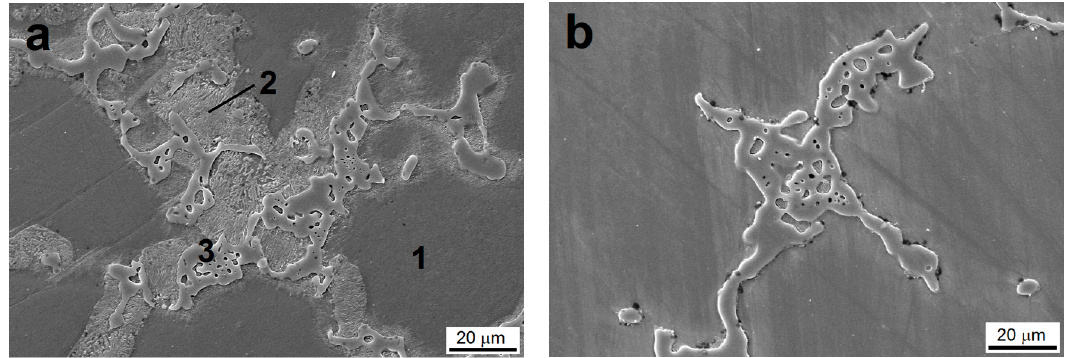
Figure 2. Microstructure of the AZ91 Mg alloy ( a ) as-cast, ( b ) heat-treated at 400 °C for 1